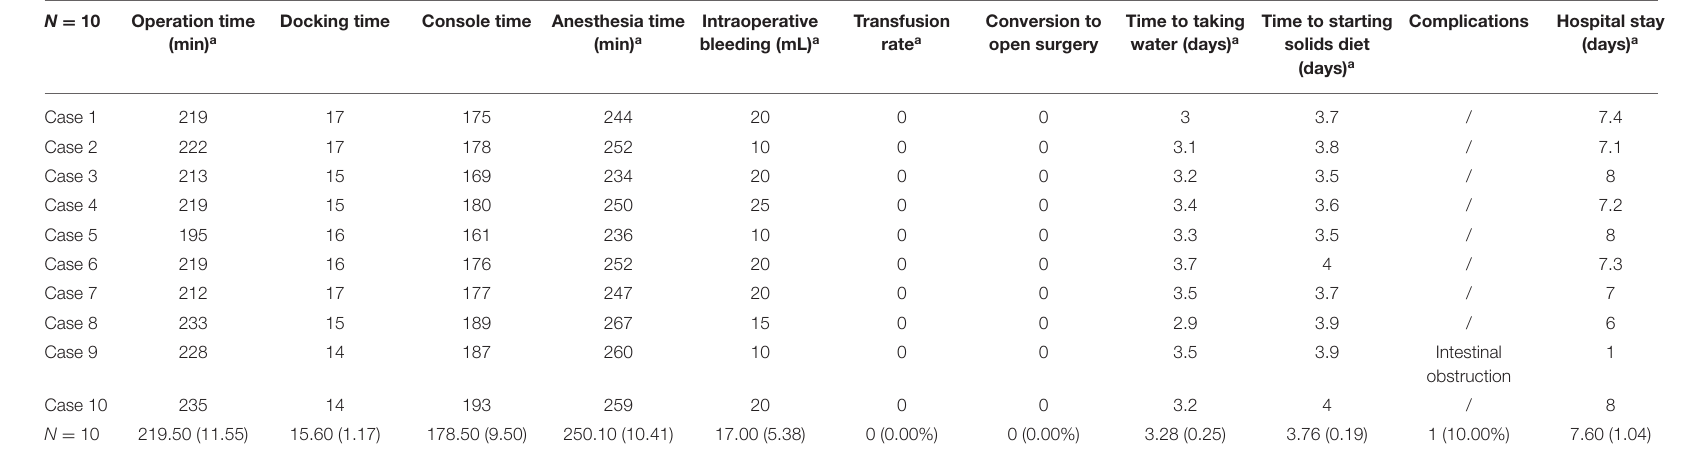
TABLE 2 | Intraoperative and postoperative outcomes and